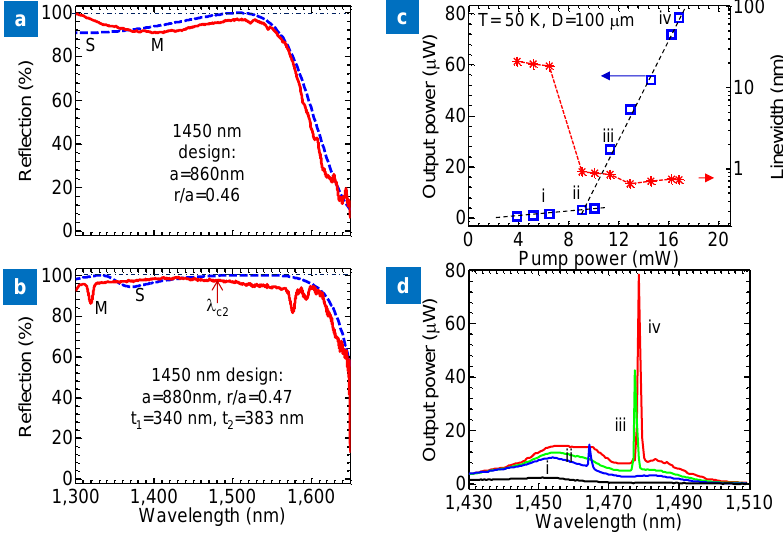
Figure 11. Reflections of top and bottom membrane reflectors (MRs). ( a ) and ( b ) for LT cavity design; ( c ) The L-L plot (light output for different pump powers) and the corresponding spectral linewidths at T = 50 K; ( d ) The measured spectral outputs for pump powers below, at, and above thresholds. Reproduced with permission from